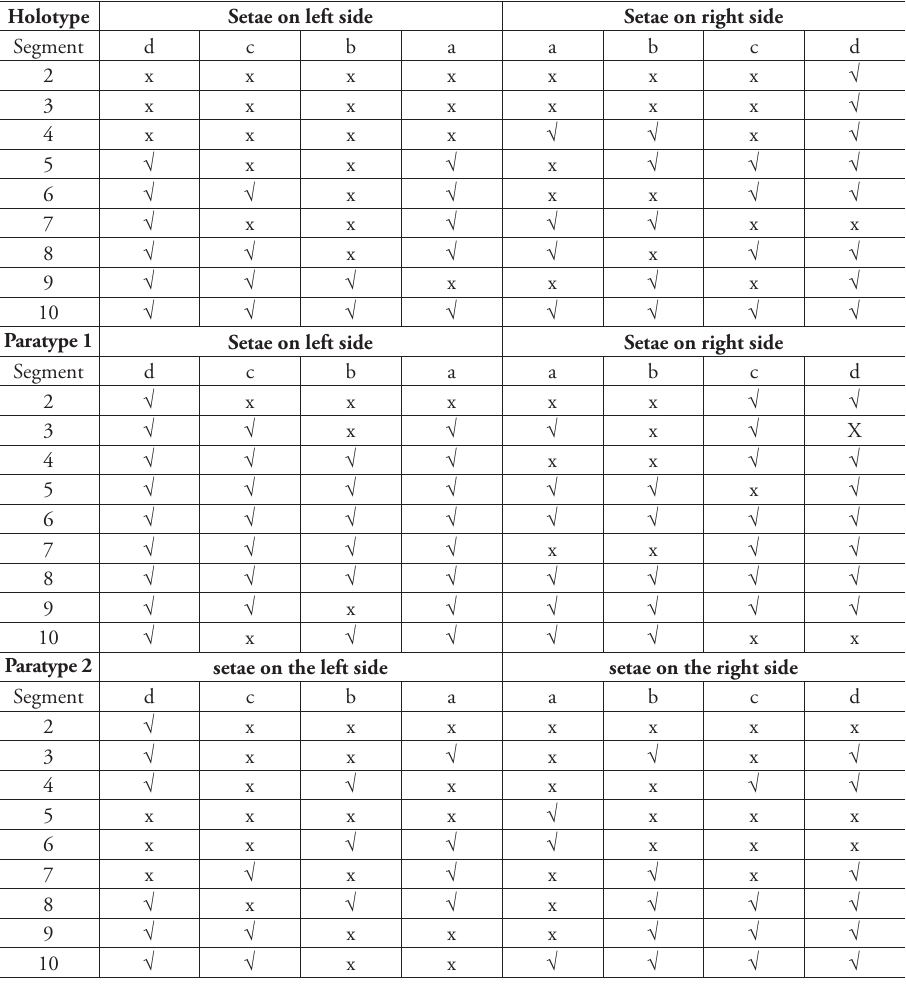
Table 1. Presence (√) or absence (x) of setae on some anterior segments of the type materials. Holotype Setae on left side Setae on right side Segment